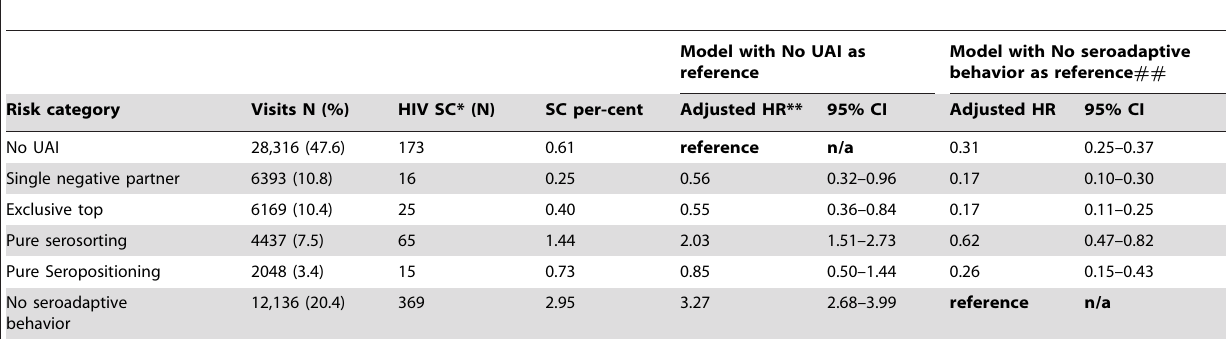
Table 2. Adjusted relative hazards of HIV seroconversion (without accounting for condoms) among North American men who have sex with men from four longitudinal cohort studies, 1995–2007.